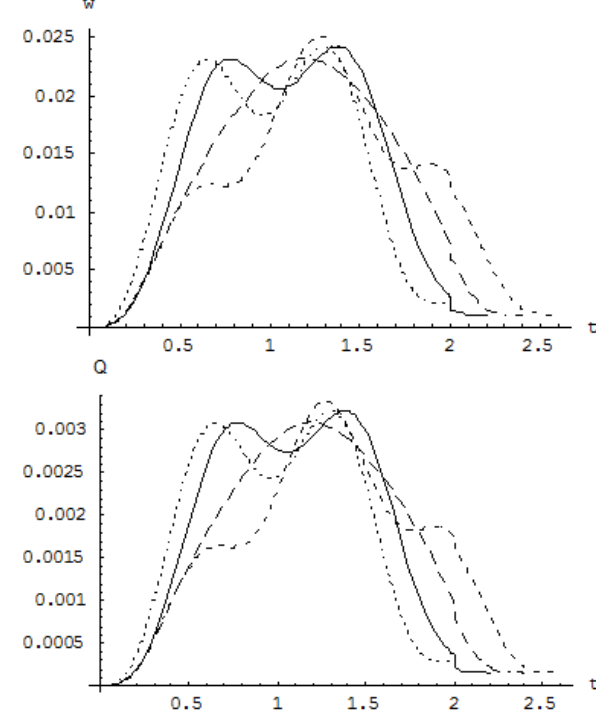
Figure 28: The influence of the vehicle length for R = 100 m, υ = 30 m/s, e H = 3.00 m, e V = 1.20 m and d = 3 m ( __ ), d = 5 m ( _ _ ), d = 7 m (- - - ) and d = 0 m ( .... ).